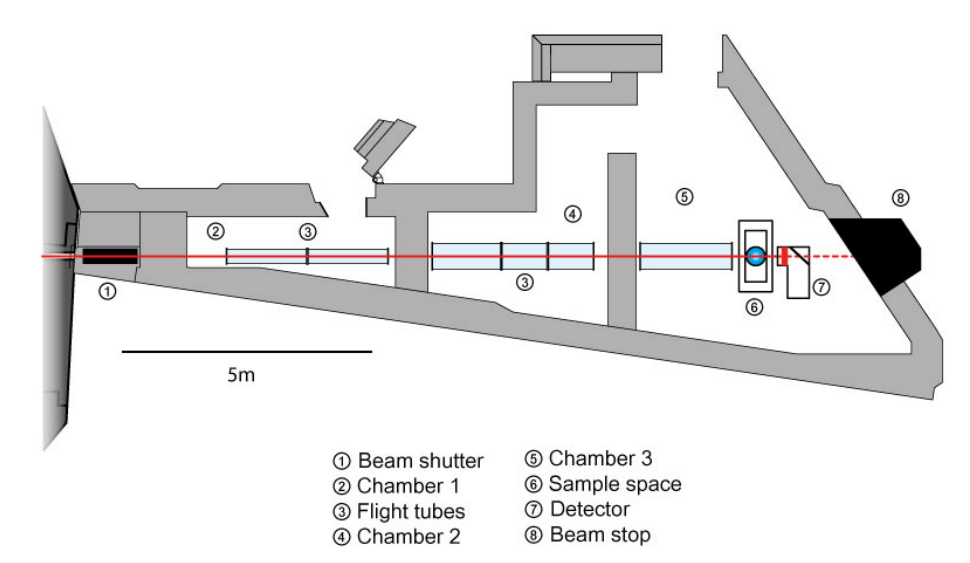
Figure 2: Schematic drawing of